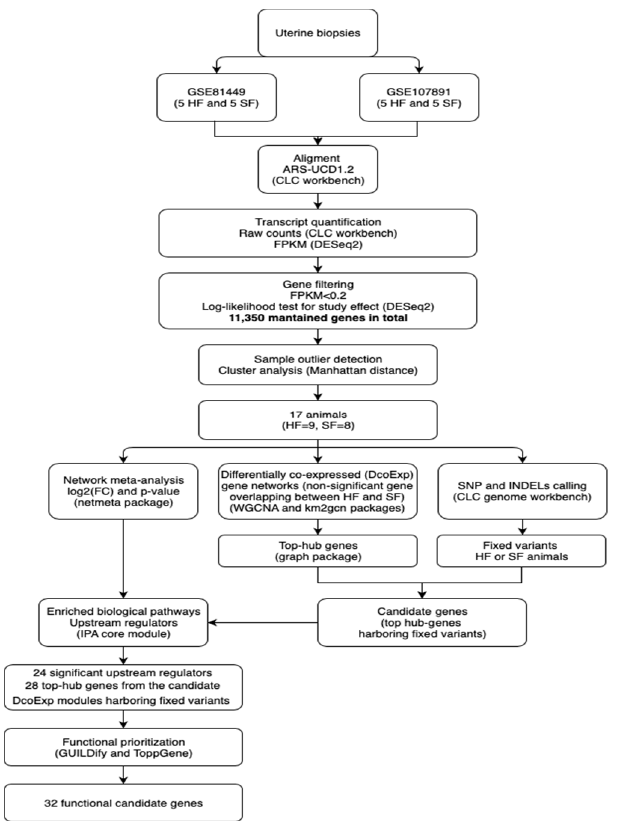
Figure 1. Pipeline for identification of functional candidate genes regulating differentially co-expressed gene networks between high-fertile and sub-fertile beef cows. SF, sub-fertile; HF, high-fertile; INDEL, insertion and deletion; SNP, single nucleotide polymorphism; FPKM, fragments per kilobase of exon model per million reads mapped; WGCNA, weighted gene correlation network analysis; IPA, ingenuity pathways analysis; FC, fold-change.